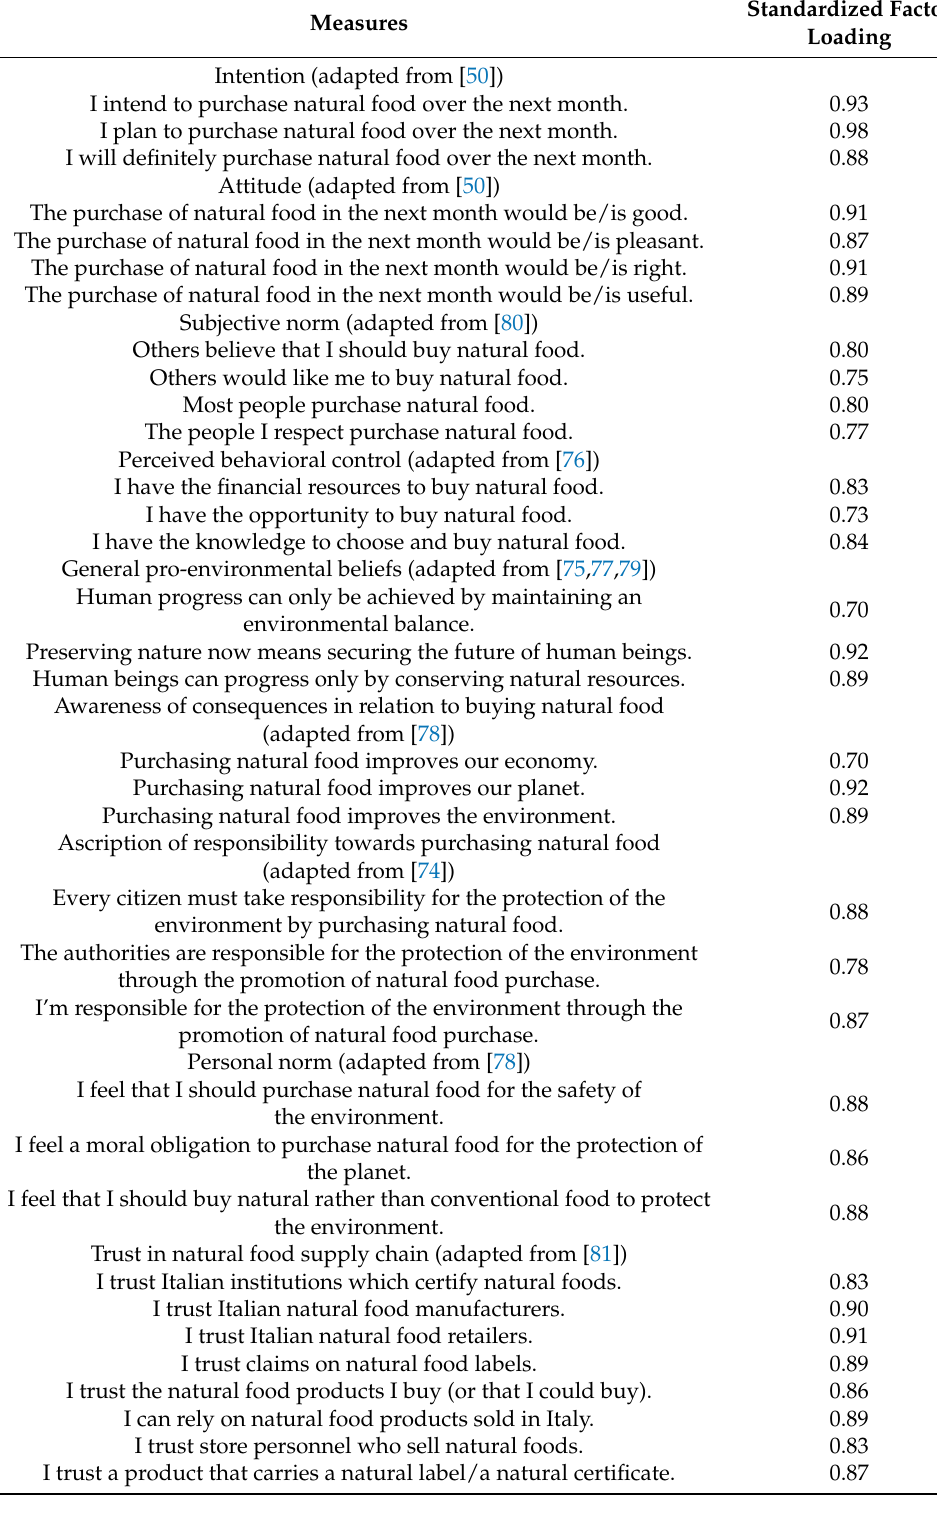
Table 1. Measures used in the survey and related standardized factor